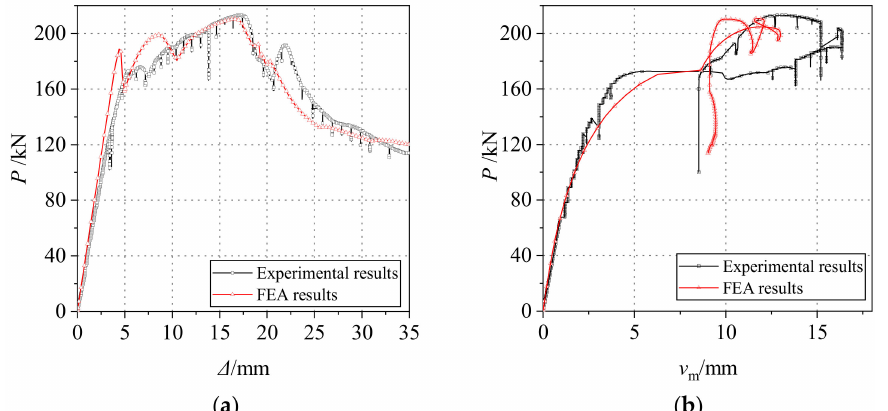
Figure 11. Comparison of the experimental and FEA results: ( a ) P - ∆ relationships; ( b ) P - v m relationships.